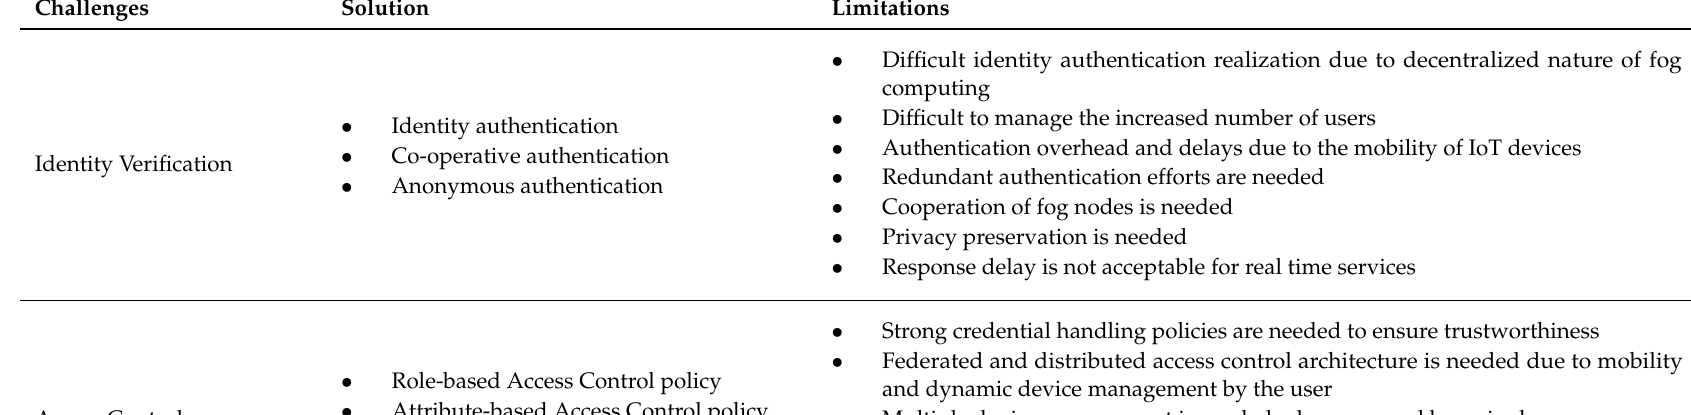
Table 3. Core-network and service level challenges and solutions with respective